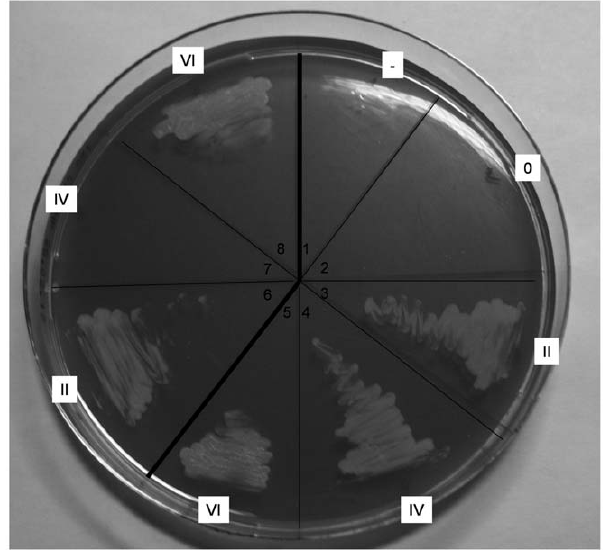
Figure 4. Growth of M. smegmatis strains on an agar plate containing ampicillin. Freshly grown cultures were diluted to